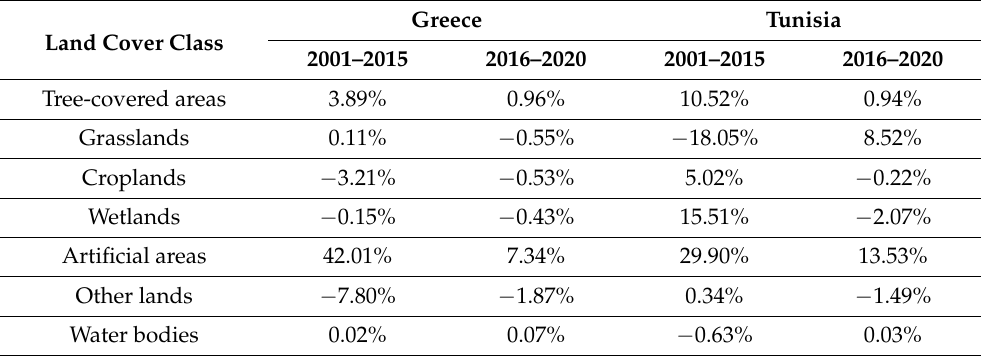
Table 5. Land cover change in area of each class of land cover (in percent) for the baseline and reporting periods in Greece and Tunisia.